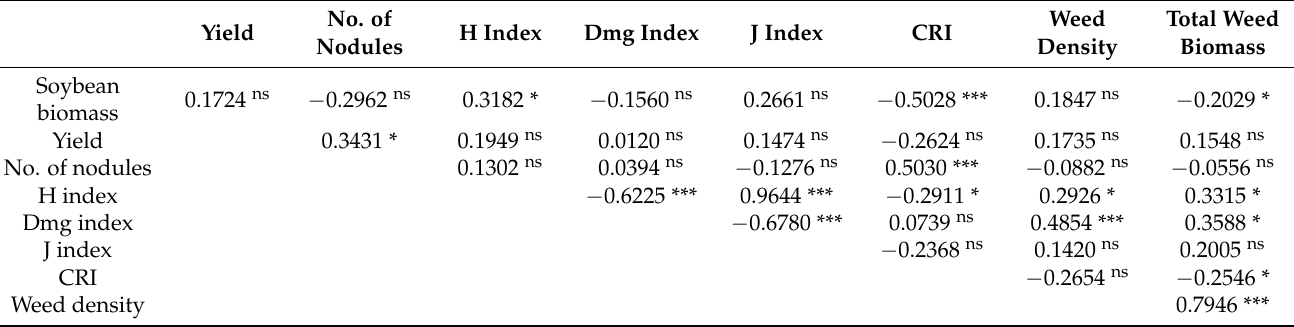
Table 7. Correlation matrix between the agronomic characteristics of soybean, the yield, the weed density and biomass, and the weed